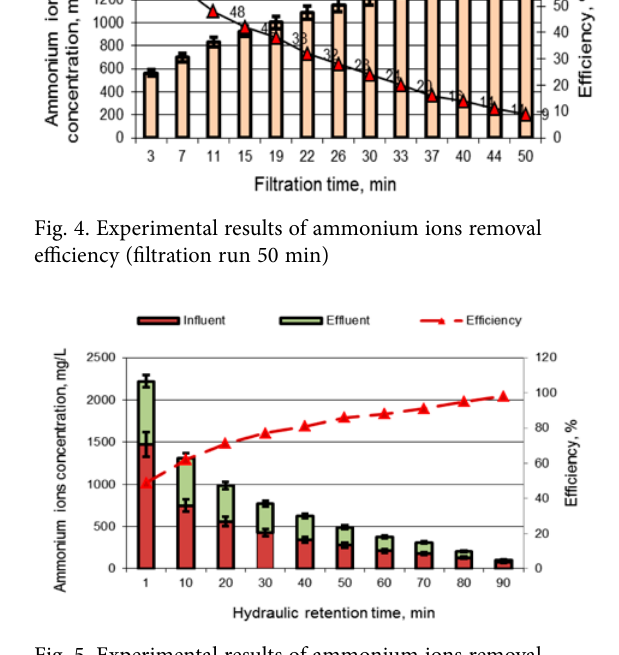
Fig. 5. Experimental results of ammonium ions removal efficiency (filtration run 90